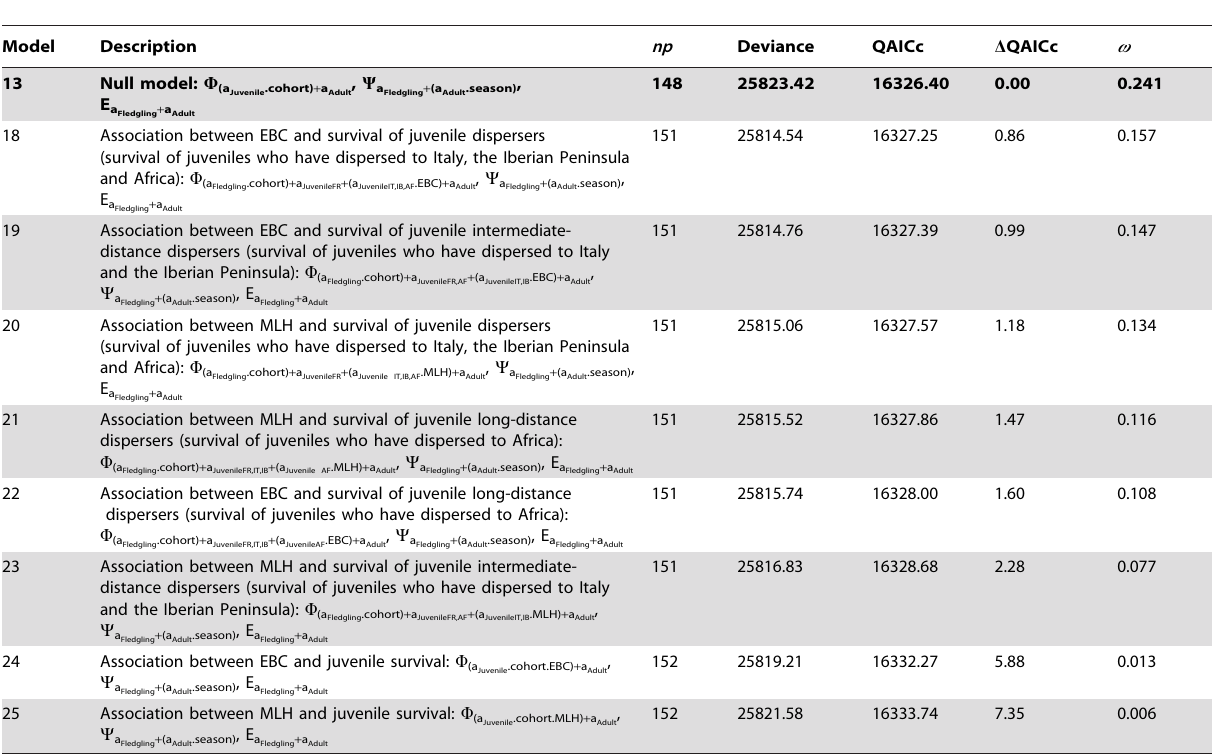
Table 1. Model selection for models evaluating an association between the life history trait of juvenile survival and the individual covariates of microsatellite multilocus heterozygosity (MLH) and early body condition (EBC).